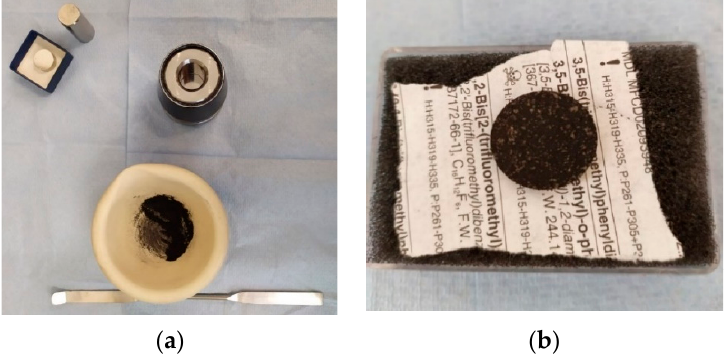
Figure 6. Pellets (16 mm diameter) die set and sample paste ( a ) and produced pellet ( b ) . The feed gas for the CO 2 uptake tests was an equimolar mixture of nitrogen and carbon dioxide at a total flow rate of 100 mL·min − 1 . All the CO 2 breakthrough curves were obtained at atmospheric pressure and varying temperatures (25 °C, 125 °C and 225 °C).